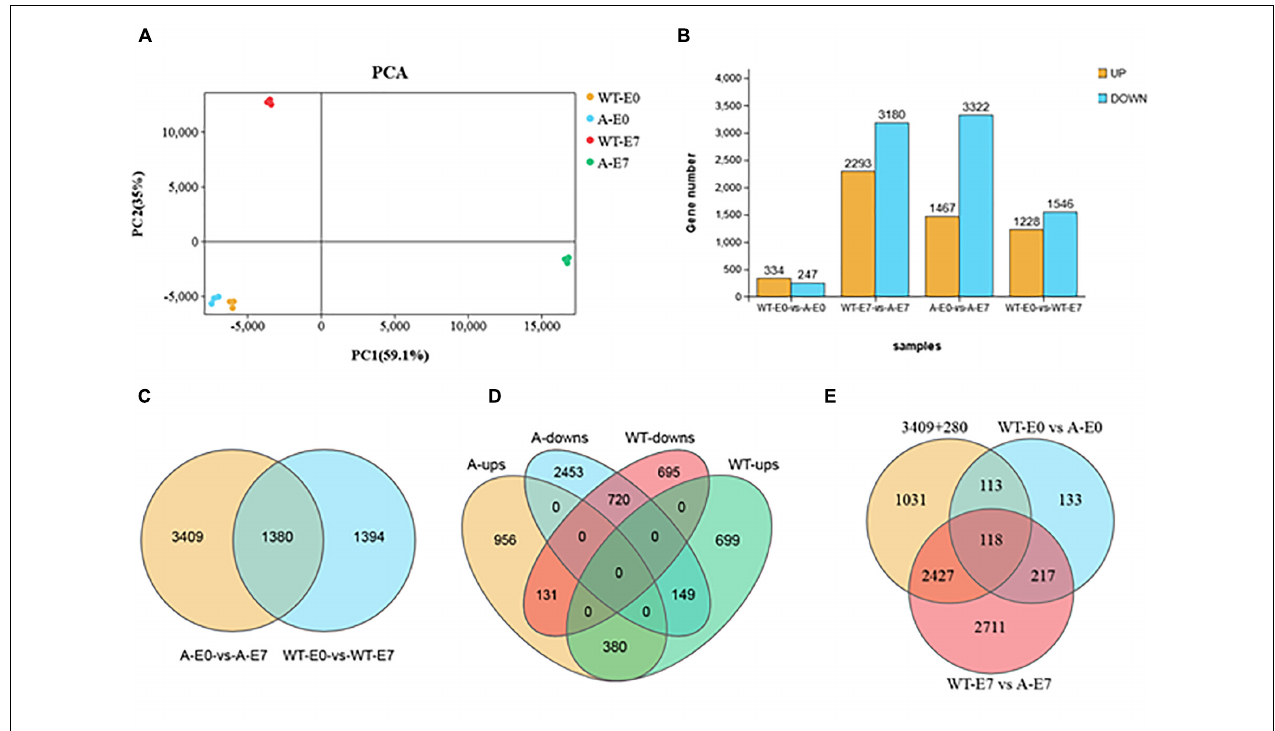
FIGURE 5 | Differentially expressed genes (DEGs) analysis in WT and SlTPL1-RNAi plants after emasculation at E0 and E7 stages. (A) Principal component analysis (PCA) of the four group samples (WT-E0, yellow; A-E0, blue; WT-E7, red, and A-E7 green); the x-axis represents the first principal component and the y-axis represents the second; (B) Histograms showing the DEGs in WT and SlTPL1-RNAi plants after emasculation at E0 and E7 stages; (C) Venn diagrams showing the overlapping DEGs during fruit set process (E0 vs. E7) in ovaries of emasculated WT and SlTPL1-RNAi flowers; (D) Venn diagrams showing the overlapping DEGs of up-regulated and down-regulated DEGs during fruit set process (E0 vs. E7) in ovaries of WT and SlTPL1-RNAi flowers; (E) Venn diagrams showing the overlapping DEGs between 3689 specifically expressed genes during fruit set process and DEGs differently expression in WT and SlTPL1-RNAi ovaries at E0 and E7 stages. WT-E0: ovaries of wild type tomato at 0 day after emasculation; WT-E7: ovaries of wild type tomato at 7 days after emasculation; A-E0: ovaries of SlTPL1RNAi tomato at 0 day after emasculation; A-E7: ovaries of SlTPL1RNAi tomato at 7 days after